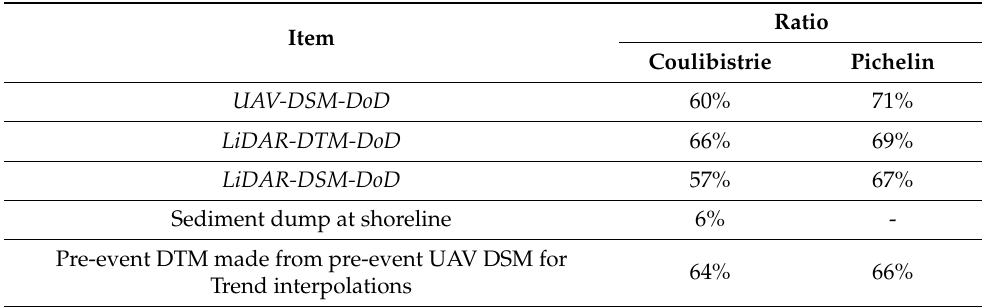
Table 4. The percentage of filled (or masked-out) area for different products of DTM and DSMs analysis.